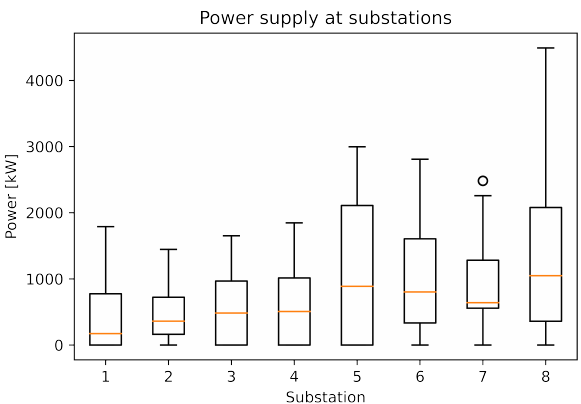
Figure 11. Hybrid scenario charging